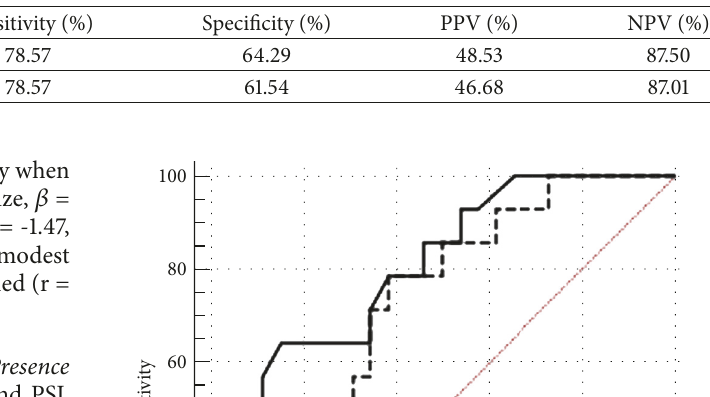
Table 3: Performances of spleen size and PSL in predicting HRV at gastroscopy within 12 months in patients with NCPH. Sensitivity, specificity, PPV, and NPV values are calculated for a threshold of > 17.2cm for spleen size and ≤ 5.21 for PSL, with HRV prevalence of 30%. AUROC, area under receiver-operator characteristic curve; PPV, positive predictive value; NPV, negative predictive value; PSL, platelet count-spleen length ratio.